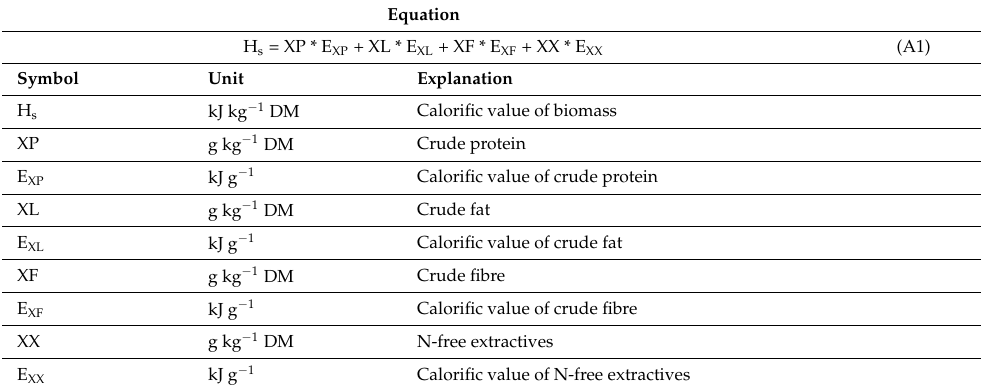
Table A5. The energy content (calorific value) of plant biomass has been determined with Equation